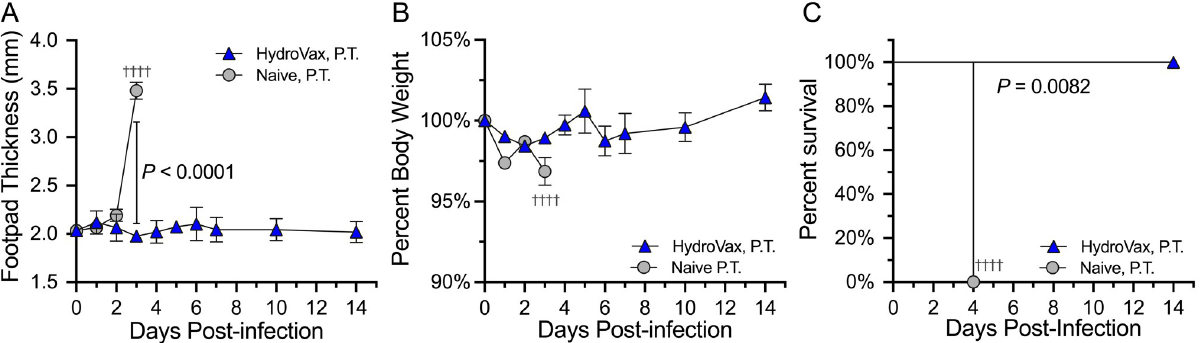
Fig 6. Vaccine-induced serum antibodies protect against lethal CHIKV challenge. Pooled immune sera from HydroVax-CHIKV vaccinated C57BL/ 6 mice, or matched na ï ve controls, was administered to AG129 mice ( n = 4 per group) one day prior to heterologous footpad challenge with 1,000 PFU of CHIKV-SL15649. Group average footpad thickness values (A) or change in weight (B) are provided with ± SEM. Significant differences in footpad swelling at 3 days post-infection were determined using unpaired Student’s t -test. (C) Group survival comparisons were performed using the Mantel- Cox log rank test. Dagger symbols represent mortality events. P.T; passive